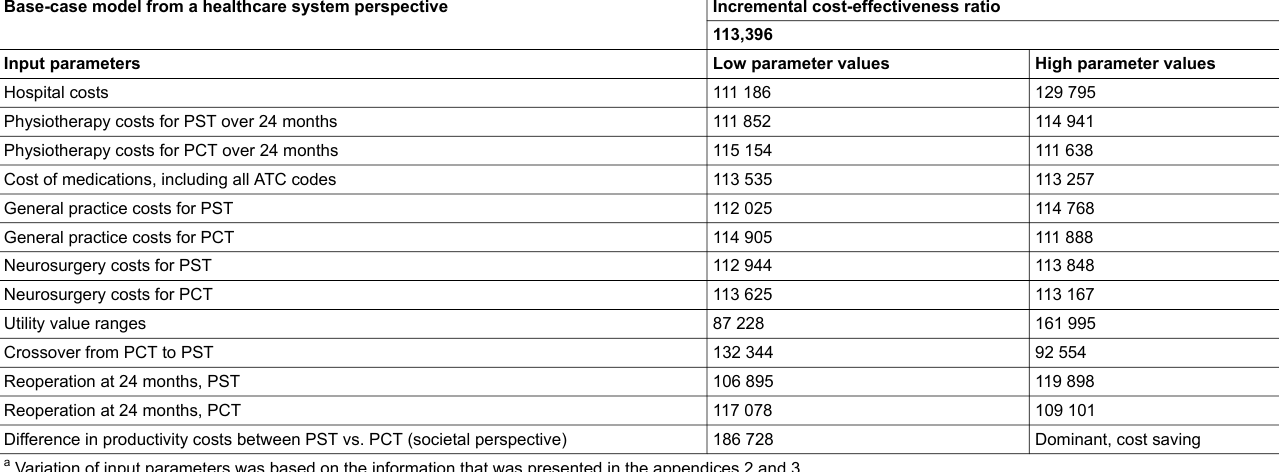
Incremental cost-effectiveness ratioBase-case model from a healthcare system